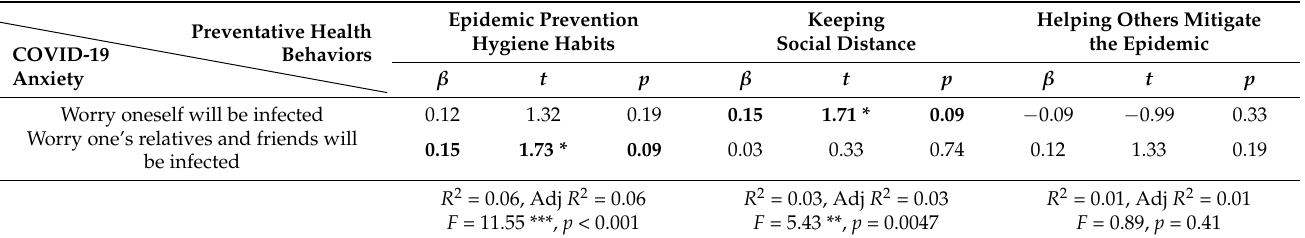
Table 2. Regression results of COVID-19 anxiety perception to preventative health behaviors.